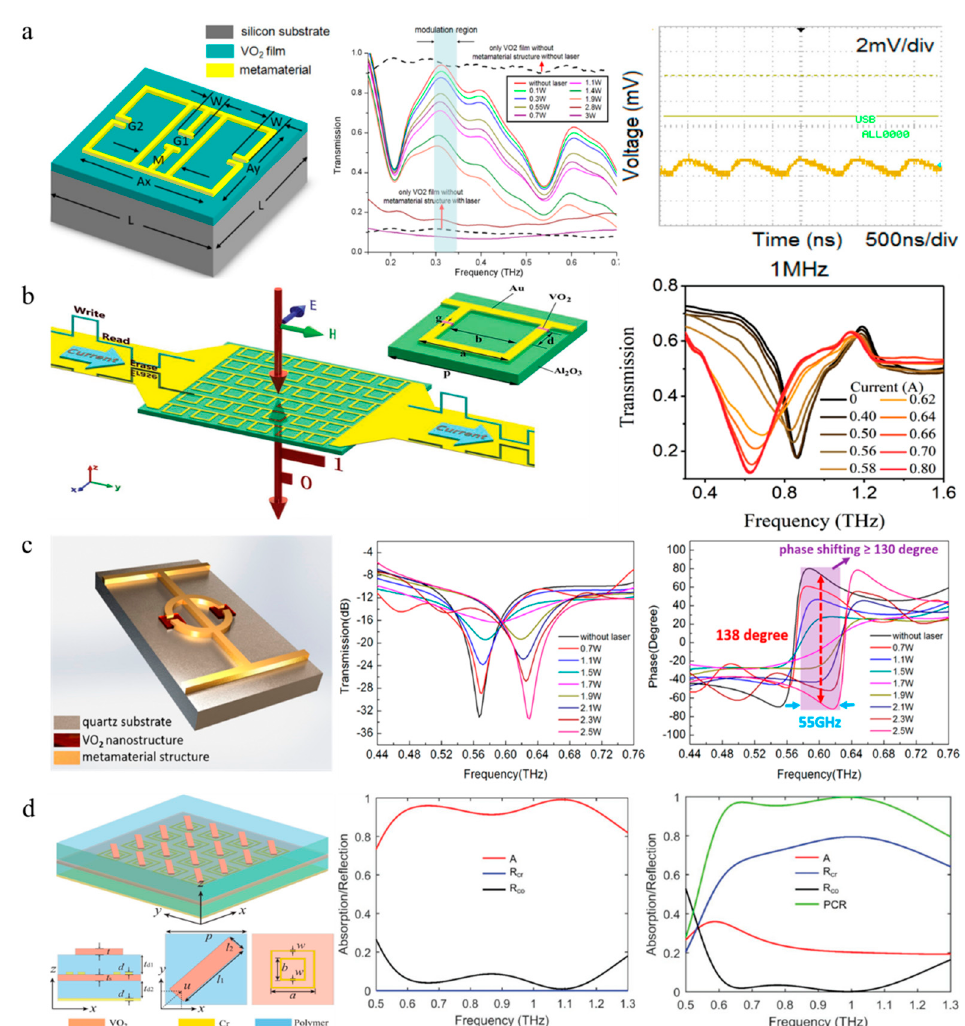
Figure 12. ( a ) Schematics for one unit. The transmission of the device decreases with increasing laser-power. The planes on the right shows the output of a 1 MHz pump laser signal. Reproduced with permission from [130]. ( b ) Schematic of the multifunctional metasurface and experimental transmission with different applied currents. Reproduced with permission from [132], copyright John Wiley and Sons, 2018. ( c ) Three dimensions of one cell and experimental results of the transmission spectra and phase spectra with TDS. Reproduced with permission from [27], copyright, American Chemical Society, 2018. ( d ) Structure of the multifunctional metasurface and the simulated data of vanadium dioxide (VO 2 ) in an insulating state and a fully metallic state are also illustrated. Reproduced with permission from [140], copyright John Wiley and Sons, 2018.